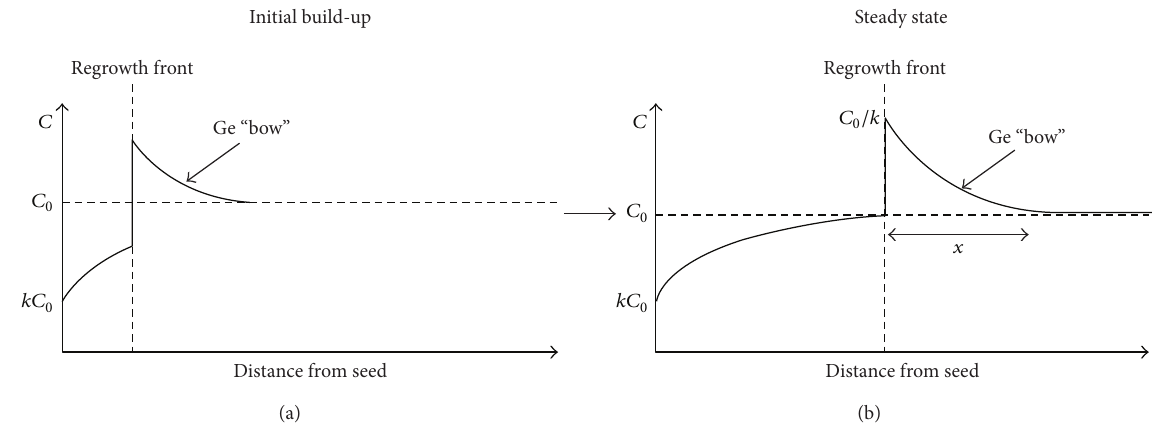
Figure 7: Diagram showing steady-state solidification. (a) Initial build-up and (b) steady-state solidification.